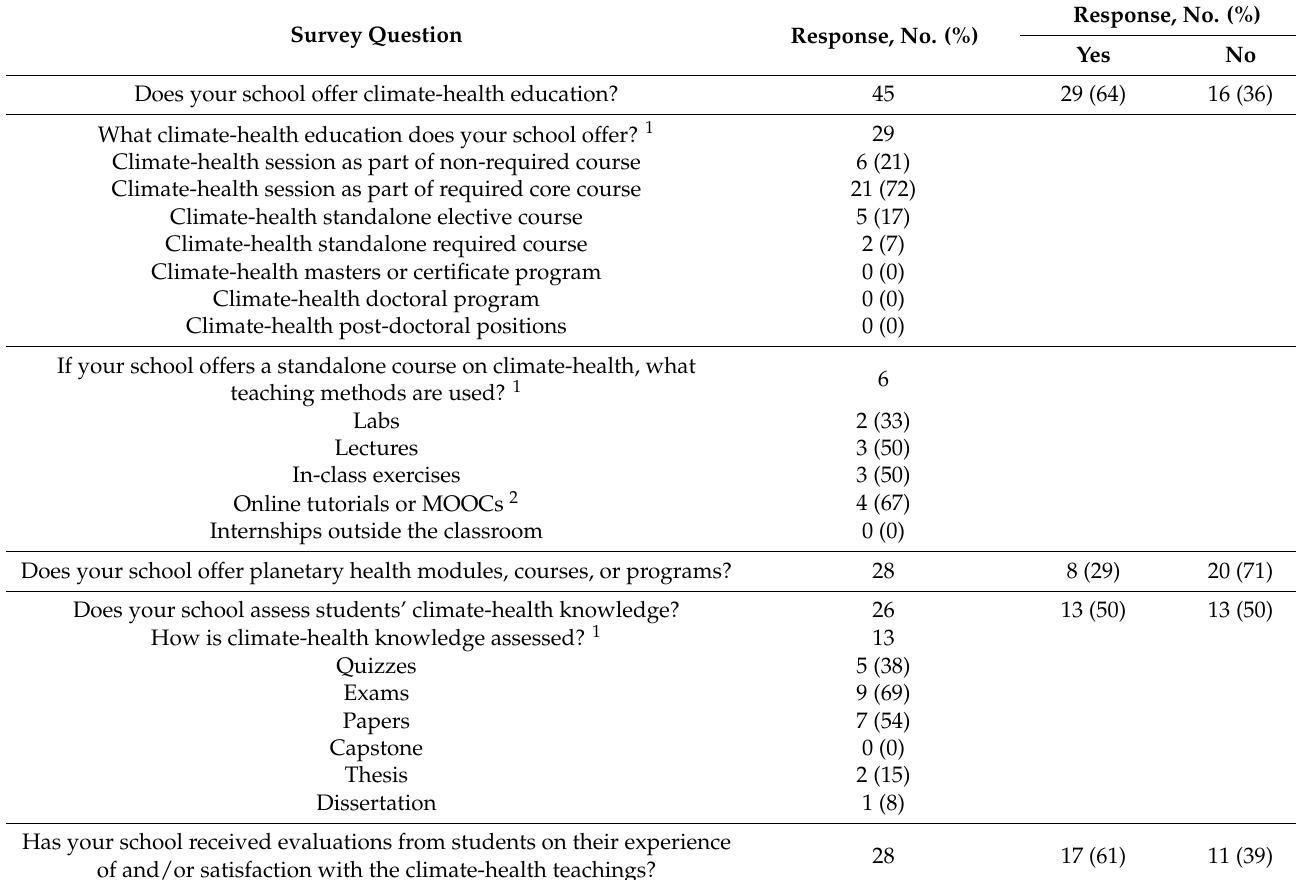
Table 1. Climate-health educational offerings, assessments, and